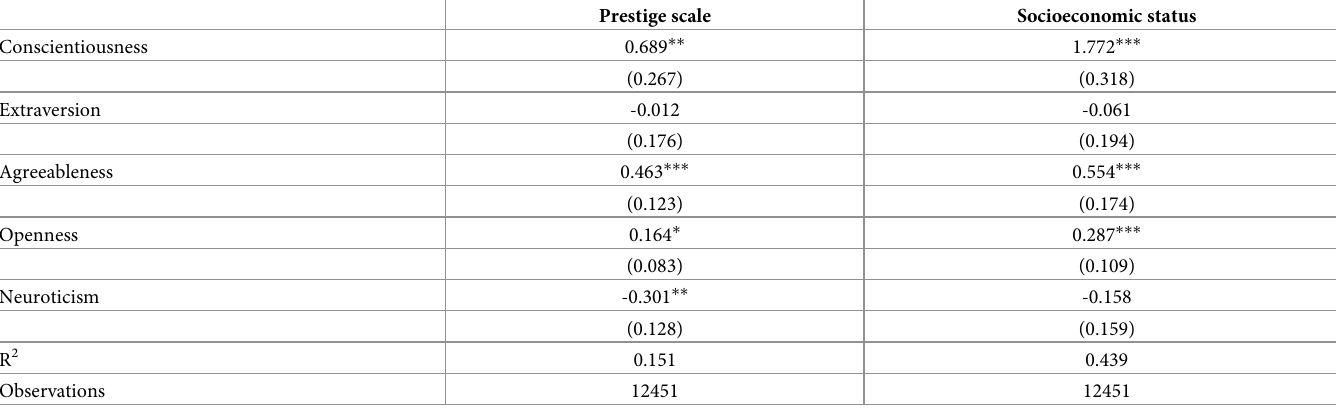
Table 4. Personality traits and occupational prestige and socioeconomic